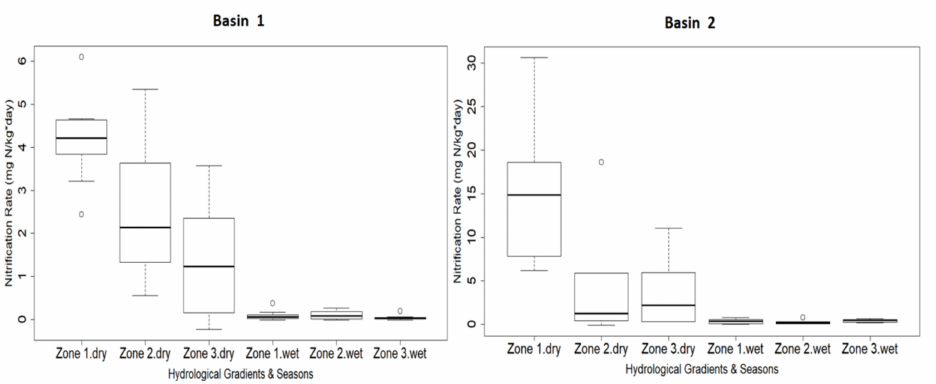
Figure 4. Nitrification rates of SIB soils by zones and seasons. Zone 1, frequently flooded; Zone 2, ocassionally flooded; Zone 3, rarely flooded. Values represent data from the entire soil profile (all three sampling